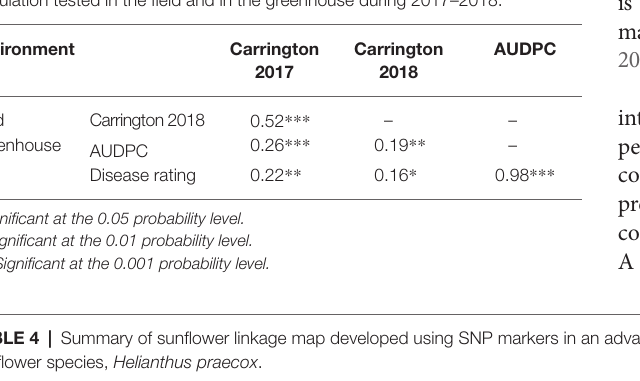
TABLE 3 | Spearman’s rank correlations ( ρ ) between Sclerotinia basal stalk rot disease data among individuals of the HA 89/ Helianthus praecox AB-QTL population tested in the field and in the greenhouse during 2017–2018. Environment